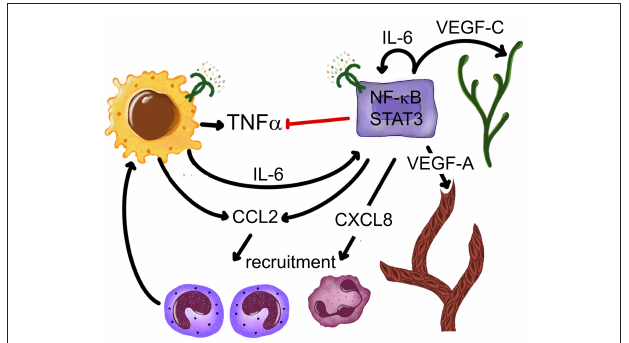
FIGURE 3 | Outcomes of interactions between OSCC cells, monocytes and a TLR4 ligand E. coli LPS. OSCC cells selectively inhibit LPS-induced TNF-alpha production in monocytes-macrophages without disrupting IL-6. OSCC and monocyte-macrophage-derived IL-6 activates STAT3 in most cells. LPS-induced CCL2 and CXCL8 recruit monocytes and neutrophils IL-6-induced STAT3 activation upregulates VEGF-A and VEGF-C production, stimulating vasculogenesis and lymphangiogenesis, respectively. References: Kurago et al. [109], Lam-ubol et al. [179], Palani et al. [96], Rajarathnam et al. [180], and Shinriki et al.